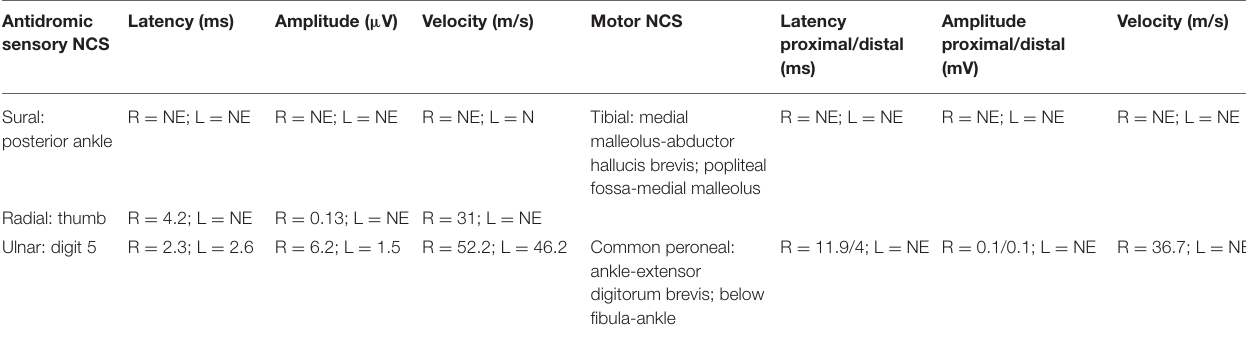
TABLE 1 | Neurophysiological